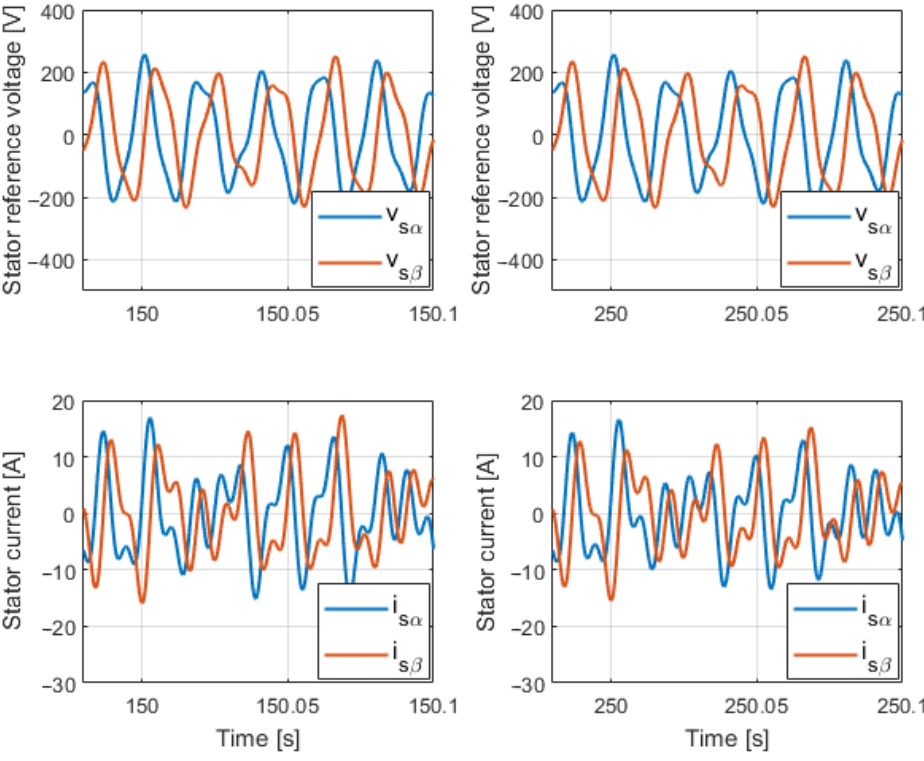
Figure 9. 120 ms of wave-forms with harmonic insertion for electrical parameters